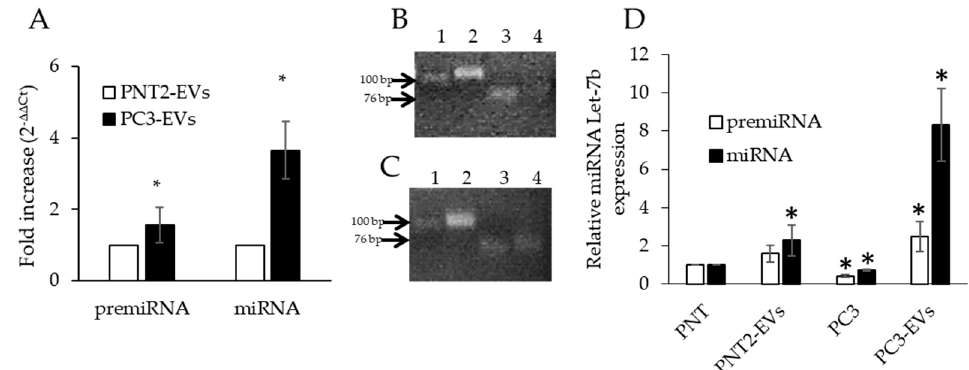
Figure 2. miRNAs Let-7b in EVs. ( A ) qPCR of pre-miRNA Let-7b and mature miRNA Let-7b in PNT2-derived EVs (PNT2-EVs) and PC3-derived EVs (PC3-EVs). Gene expression values were normalized to U6 snRNA and presented as 2 − ∆∆ Ct . Relative RNA abundance in PNT2-EVs was assumed as 1. Data represent mean ± SD ( n = 4). * p < 0.05 vs. PNT2-EVs. ( B ) Mature miRNA Let-7b (lane 3) and pre-miRNA Let-7b (lane 4) in PNT2-EVs, normalized for U6 (lane 2). ( C ) Mature miRNA Let-7b (lane 3) and pre-miRNA Let-7b (lane 4) in PC3–EVs, normalized for U6 (lane 2). ( D ) Comparative analysis of the expression levels of precursor and mature forms of prostate cells and their pEVs. Data represent mean ± SD ( n = 4). * p < 0.05 vs. PNT2.